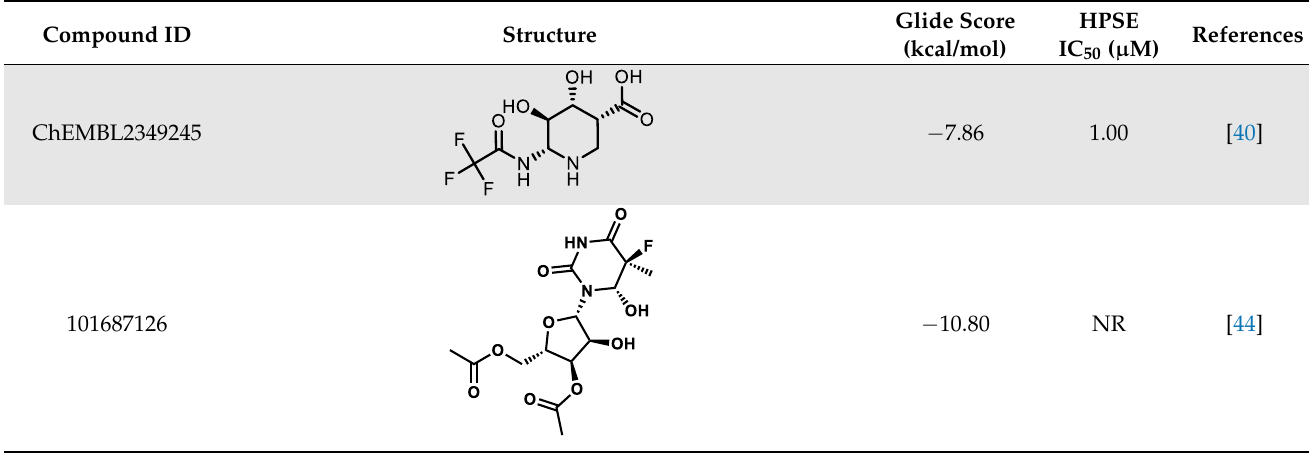
Table 2. Selected compounds computed with their respective Glide docking score and reported IC 50 values.